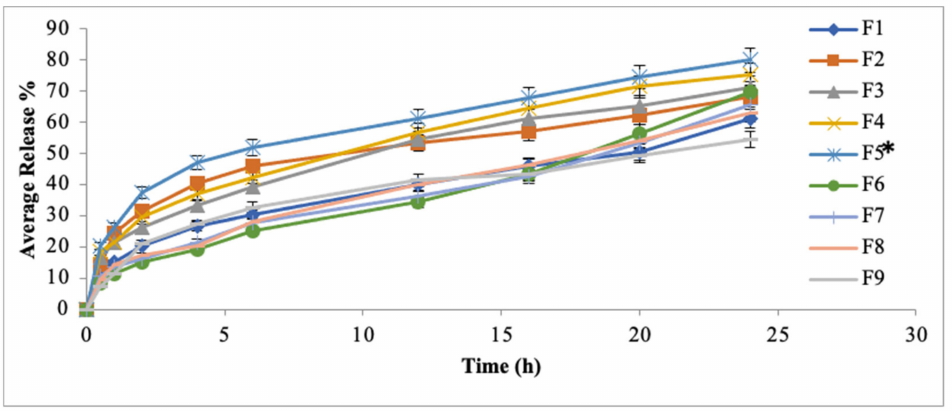
Figure 3. In vitro drug release of MTX patches. Data are expressed as mean ± SD; n = 3. One-way ANOVA followed by post hoc Tukey test ( p < 0.05), F5 vs. F1. (* p < 0.05).